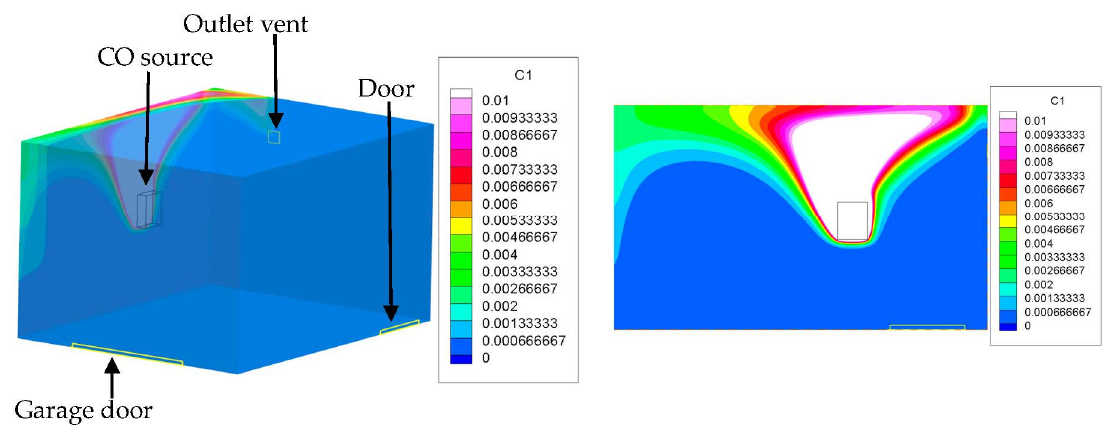
Figure 5. CO distribution in the garage—case 2 (concentration of CO in kg/kg).